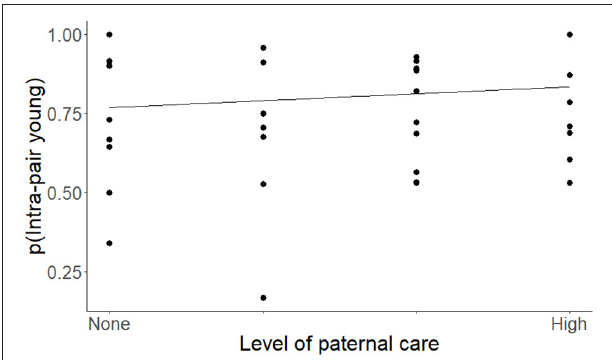
FIGURE 3 | The proportion of intra-pair young (IPY) produced by species of socially monogamous mammals with differing levels of paternal care, ranked from species that provide no paternal care to those that provide intensive paternal care. The regression is based on the coefficients from the top model for IPY ( Tables 2 , 3 ) and controls for phylogenetic relatedness, differences in social structure, and is weighted by sample